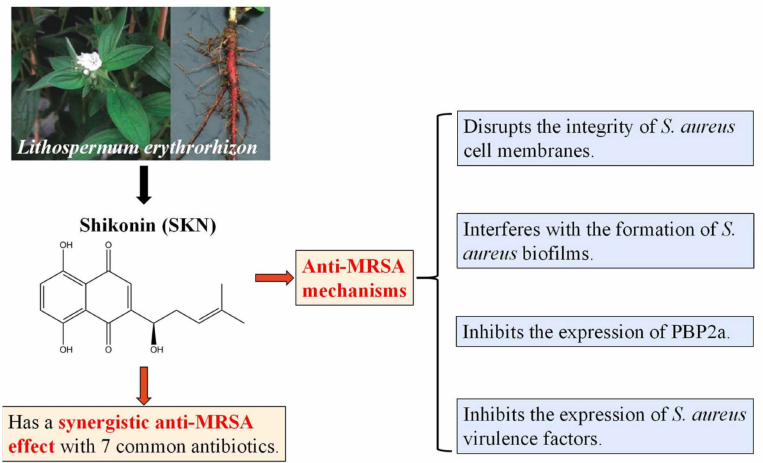
Figure 9. Schematic diagram of the antibacterial activity of shikonin (SKN) found in this